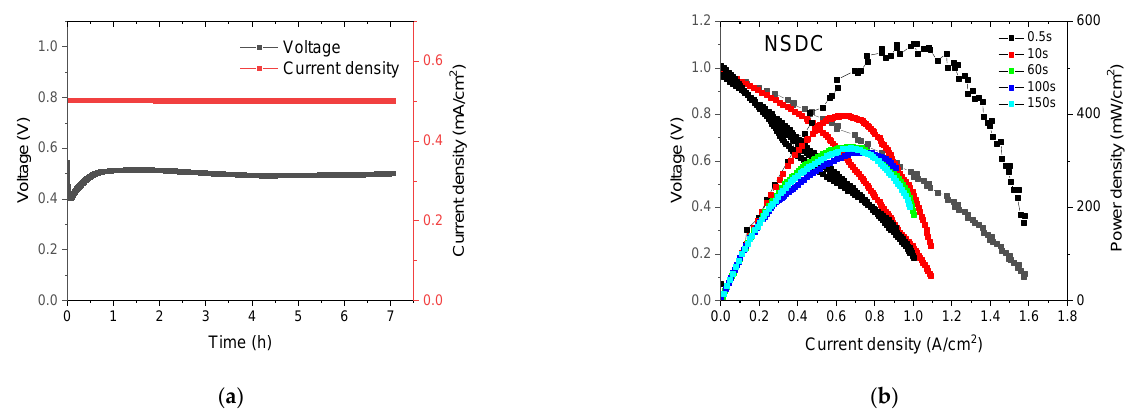
Figure 4. ( a ) Steady-state power output of NSDC cell; ( b ) Polarization curve with voltage interval 0.01 V and scanning time interval of 1 s, 10 s, 60 s, 100 s, and 200 s.